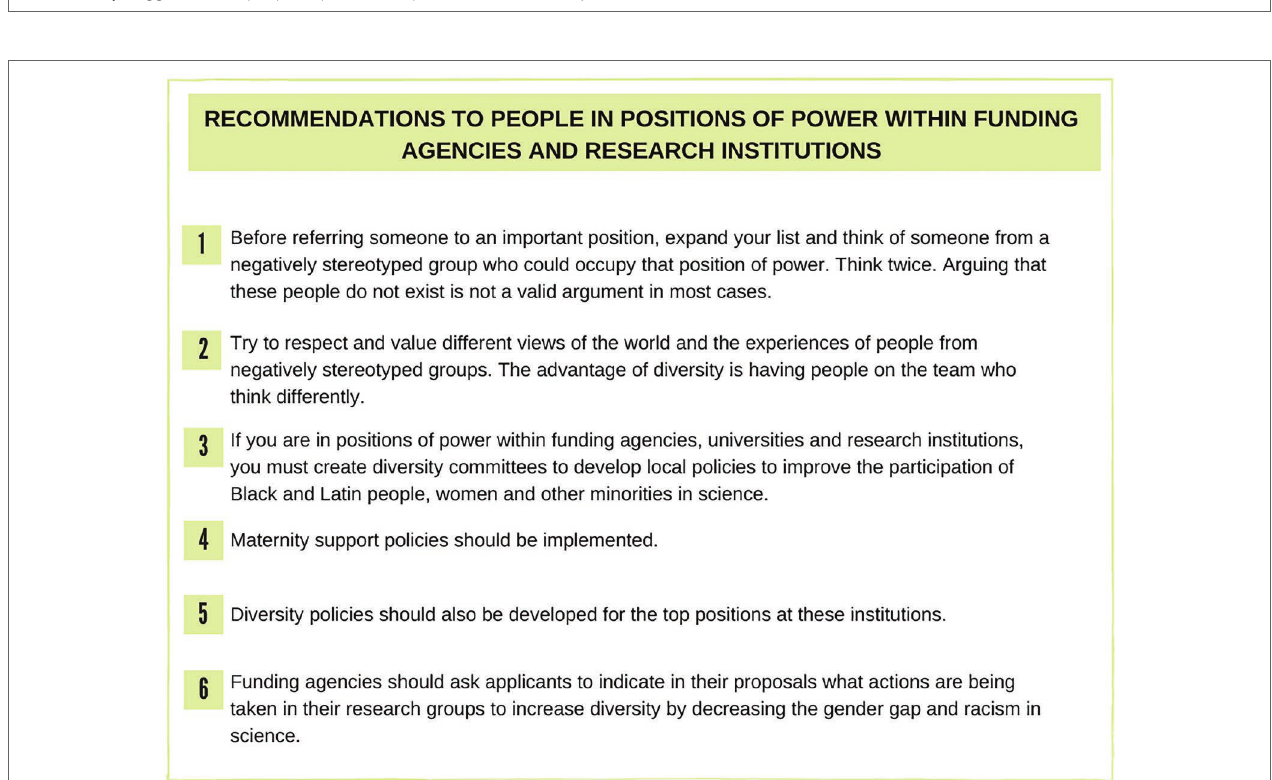
FIGURE 1 | Suggestions for people in positions of power within scientific journals.